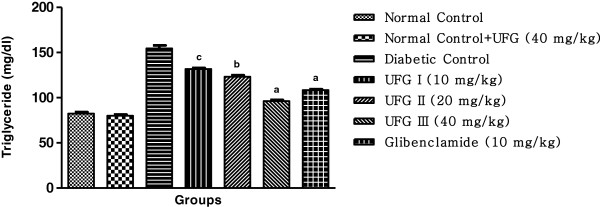
Effect of umbelliferone β-D-galactopyranoside on level of triglyceride at different concentrations on STZ induced diabetic rats, compared to diabetic control group rats; values are mean ± SEM; n = 6;
c
P < 0.05;
b
P < 0.01;
a
P < 0.001; P > 0.05 is considered as non-significant (ns).